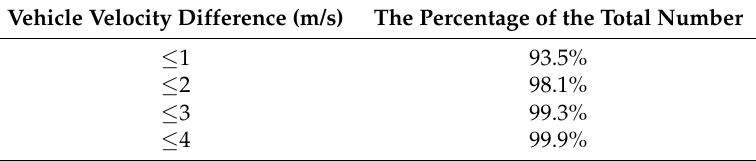
Table 4. The comparison result of the two velocity sequences.